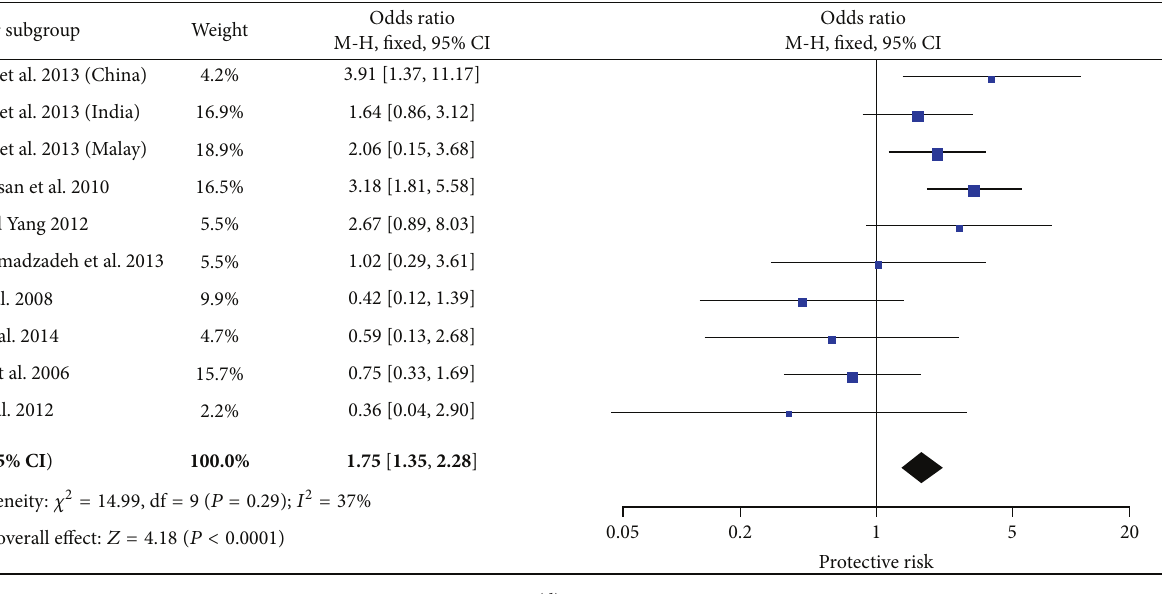
Figure 2: Forest plots of the association of LEPR p.R223Q with T2DM. The size of the box is proportional to the weight of the study, horizontal lines indicate 95% CI, and a diamond indicates the summary OR with its corresponding 95% CI. (a) Allele model, (b) dominant model, (c) homozygote model, and (d) recessive model; LEPR: leptin receptor gene; T2DM: type 2 diabetes mellitus; OR: odds ratio; CI: confidence